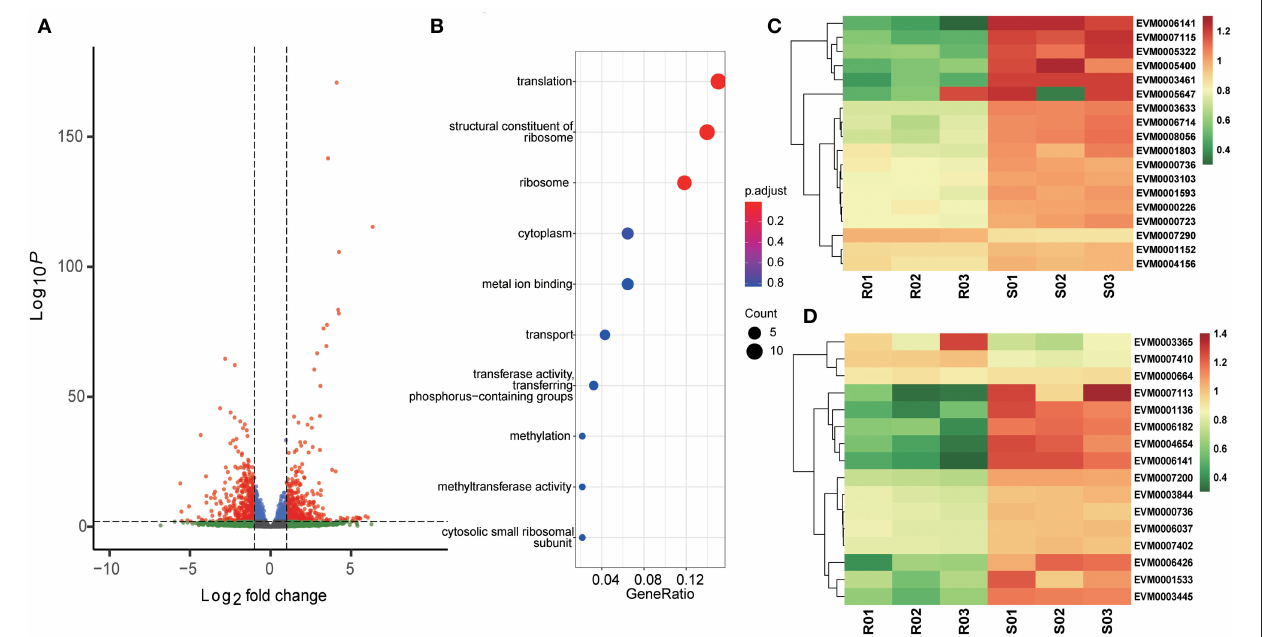
FIGURE 2 | Differential gene expression after monensin induction. The E. tenella- sensitive Houghton strain (ETH-S) underwent 16 generations of positive selection under increasing monensin concentration and then generated a monensin-resistant E. tenella line (ETH-R). (A) Volcano plot showing the difference in gene expression between ETH-R and ETH-S at 0h of monensin treatment. Genes with an absolute fold change > 2 and adjusted p < 0.01 were considered significantly differentially expressed (red dots). (B) Gene ontology enrichment analysis of differentially expressed genes between ETH-R and ETH-S at 0h of monensin treatment. Clustered heatmaps show differentially expressed genes associated with ribosomal proteins (C) and mitochondrial proteins (D) between ETH-R and ETH-S at 0h of monensin treatment. For heatmap drawing, gene expression levels were transformed into normalized log 2 (TPM +